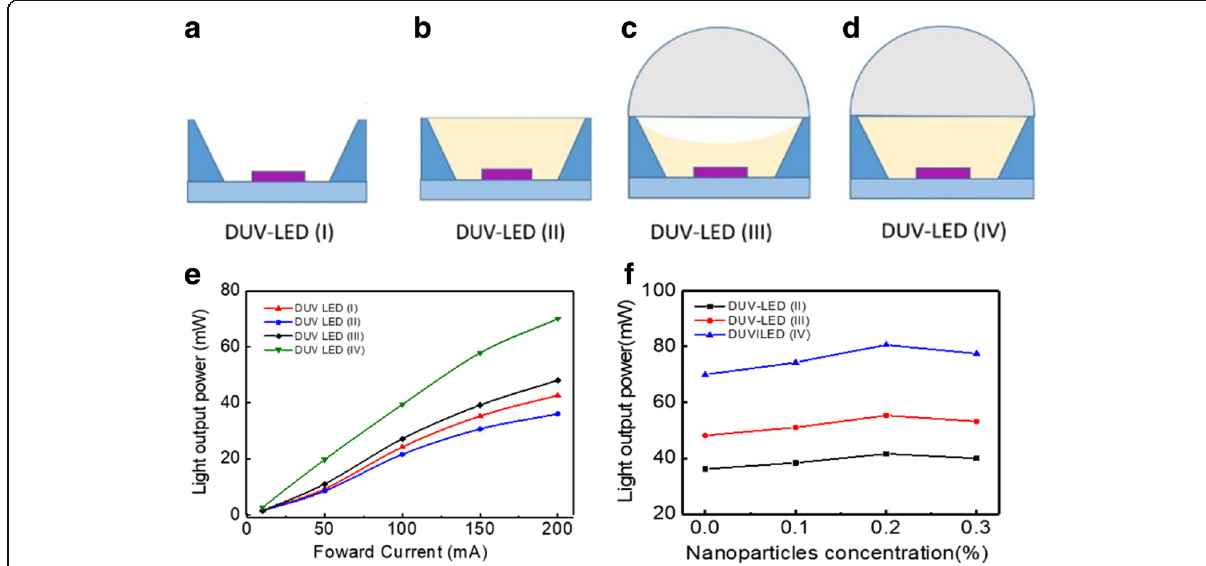
Fig. 3 Schematic and comparison of the four encapsulation structures: a DUV-LED (I), b DUV-LED (II), c DUV-LED (III), d DUV-LED (IV), e light output power under different encapsulation conditions, and f light output power with different SiO 2 NP concentrations (%) in the PDMS